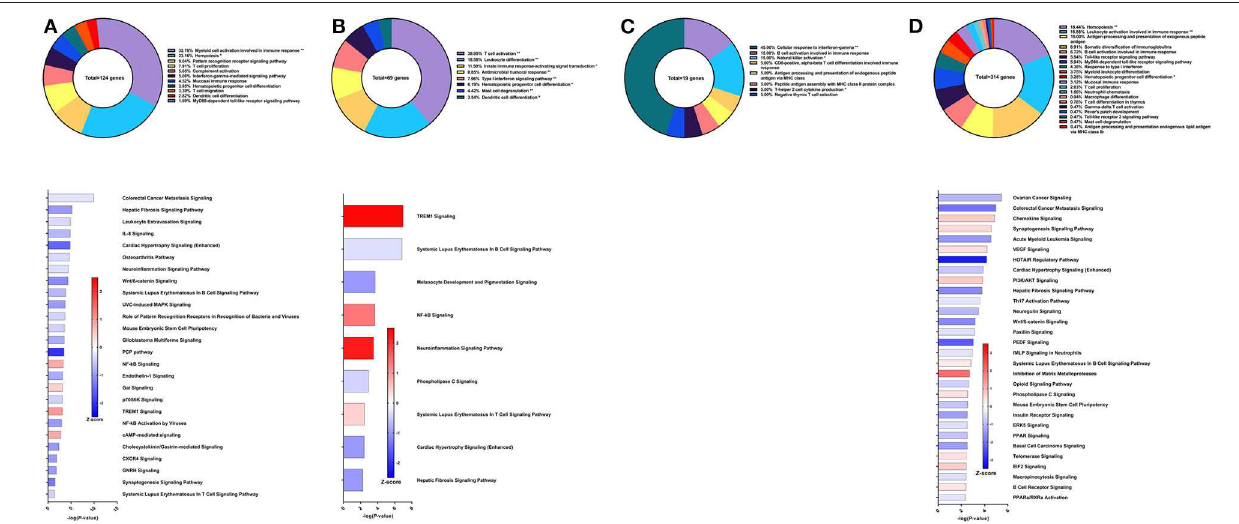
FIGURE 5 | RNA-Seq analysis of rSm-p80 + ODN10104, a recombinant protein vaccine strategy. (A) PBMCs after vaccination (Top) Gene ontology enrichment analysis represented as a pie graph of percentages of genes per group out of a total number of differentially expressed genes. “**” and “*” indicates P < 0.05 and P < 0.01, respectively. (Bottom) Canonical pathway analysis generated using IPA. Bars are plotted based on the – log10( P -value) and colored based on predicted activation (red) and deactivation/inhibition (blue) according to the Z-score, a composite assessment based on the degree of overlap between directional expression of genes from the observed data and the Qiagen-curated public database. The top 30 pathways are shown based on the lowest P -values. (B) PBMCs after challenge (Top) Gene ontology enrichment analysis. (Bottom) Canonical pathway analysis generated using IPA. (C) Spleen cells (Top) Gene ontology enrichment analysis. (Bottom) Canonical pathway analysis generated using IPA. (D) Mesenteric lymph node cells (Top) Gene ontology enrichment analysis. (Bottom) Canonical pathway analysis generated using